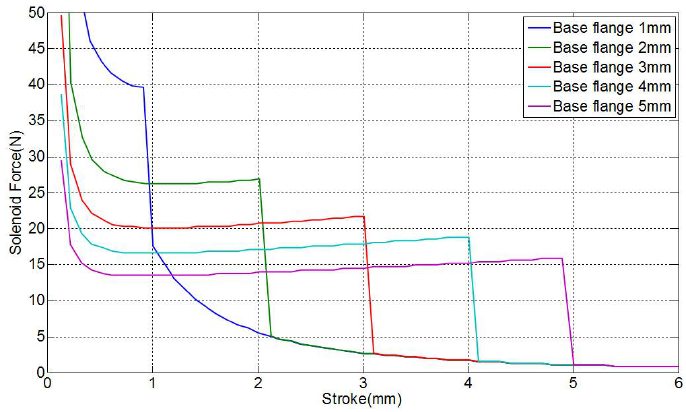
Figure 10. Simulation results of base flange.